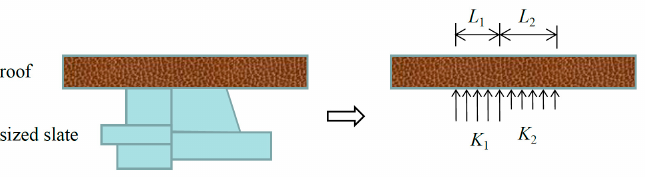
Figure 5. Schematic diagram of the grouping of supporting slates in the lower part of the roof plate. The method of direct contact between the strips and the top plate can be mainly divided into two basic forms: series and parallel connection, as shown in Figure 6.